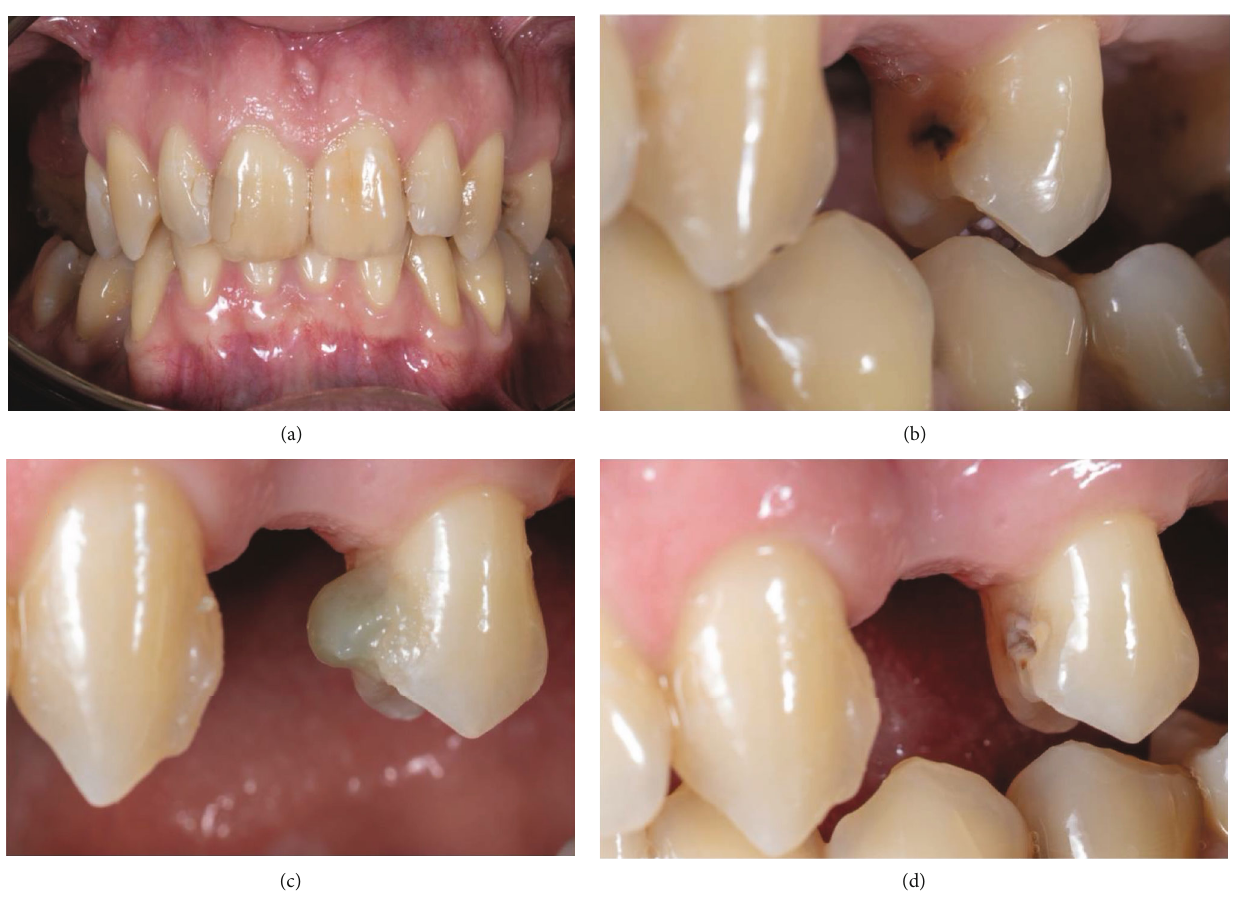
Figure 4: (a) Initial photography. (b) High magni fi cation of the cavity on the second premolar 2.5. (c) First application of BRIX3000. (d) After removing the altered